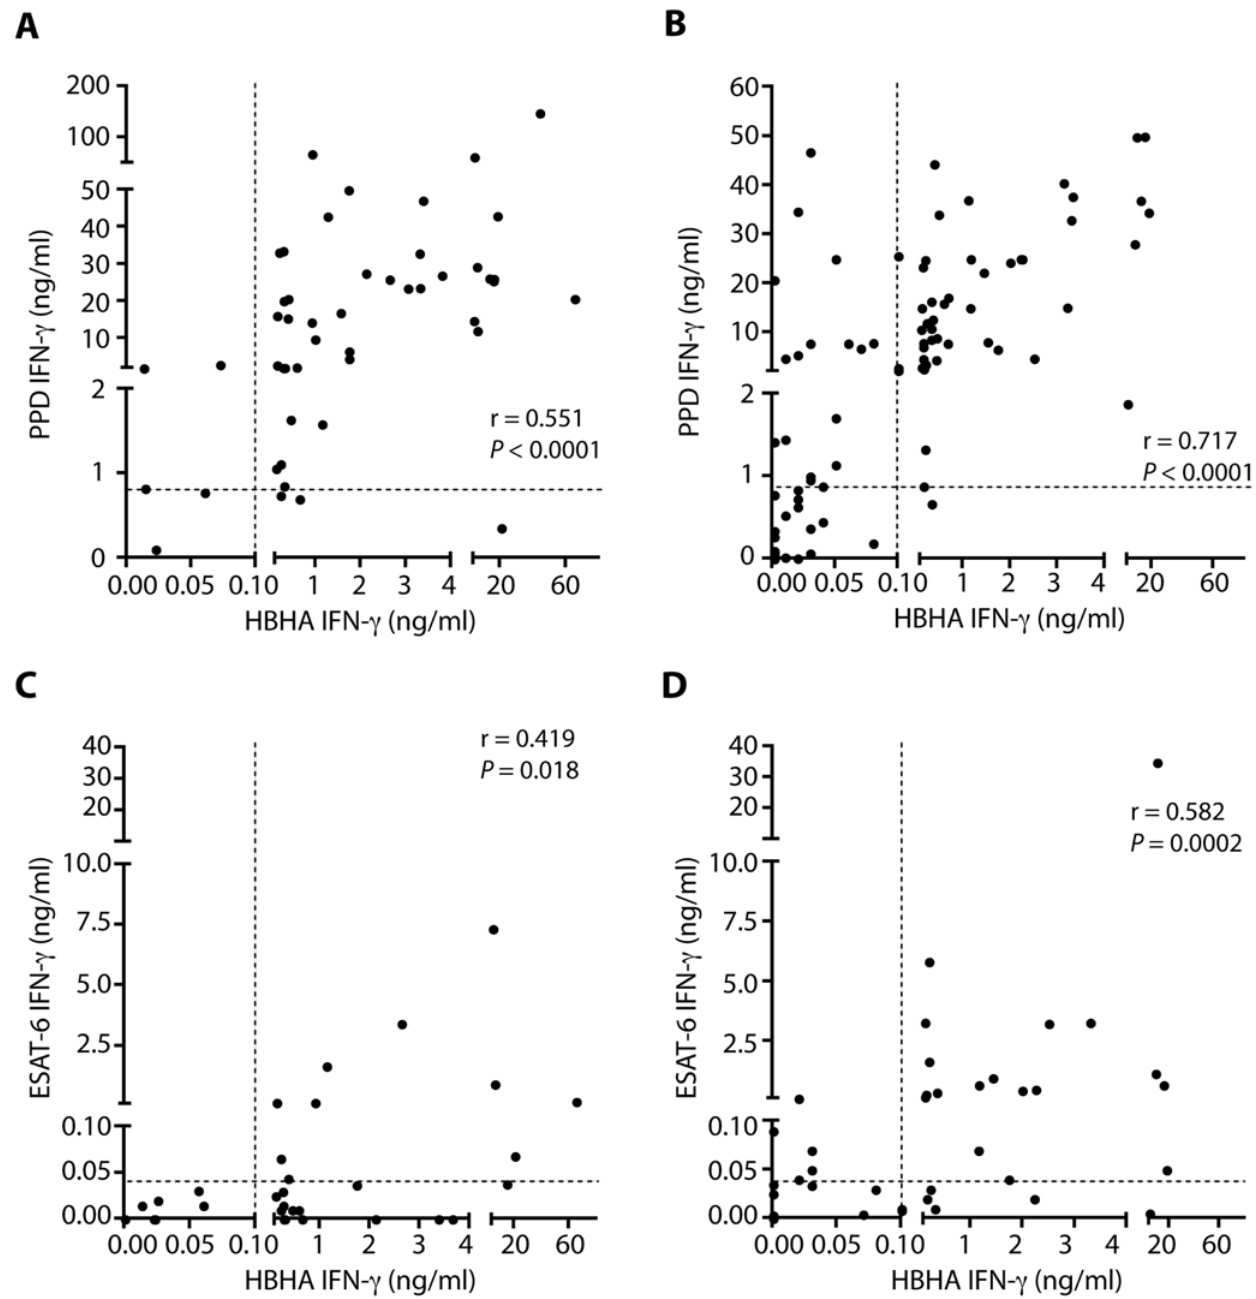
Figure 3. Correlations between the IFN- c concentrations induced by different mycobacterial antigens. Results obtained for LTBI are represented on the left panels (A, C), and those obtained for TB are on the right panels (B, D). The degree of correlation between the in vitro -induced IFN- c concentrations by the different mycobacterial antigens is represented for PPD and HBHA (A and B) and for ESAT-6 and HBHA (C and D). The dotted lines indicate the positivity cut-off for each